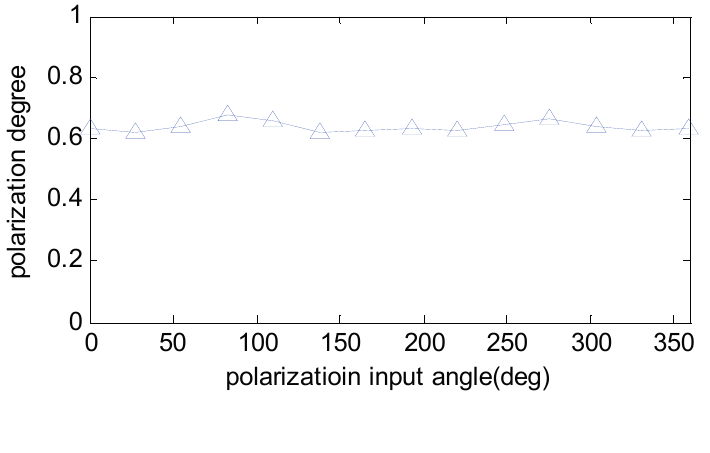
Figure 13. The computed polarization degree of outdoor